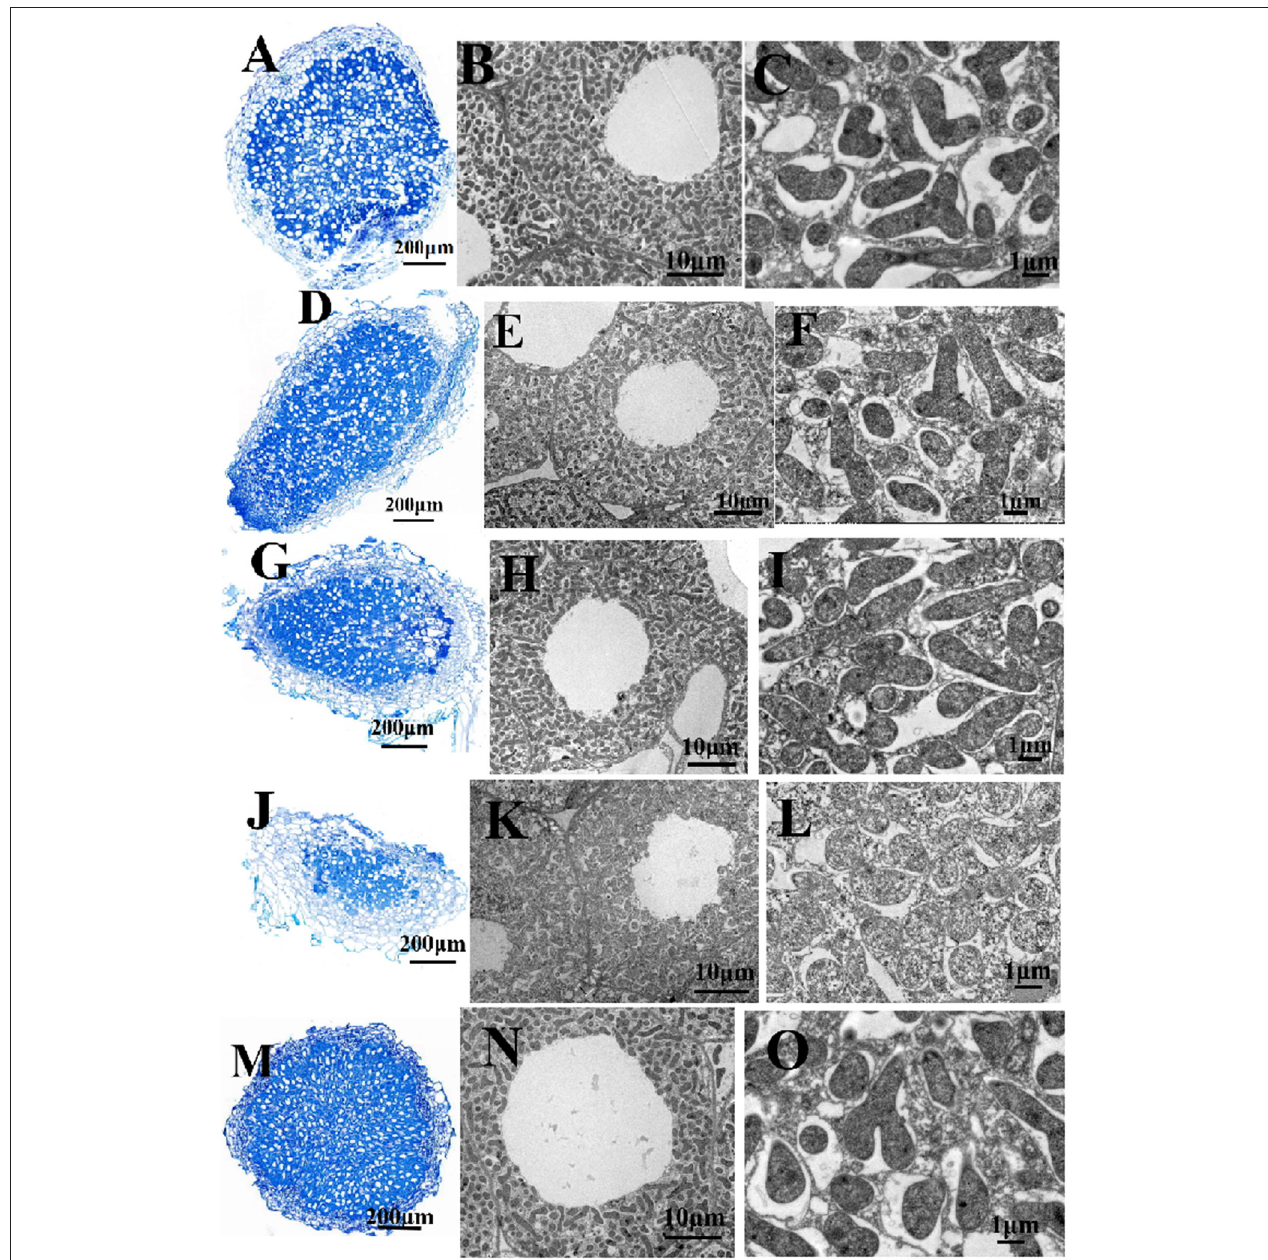
FIGURE 3 | Structure of pea nodules and bacteroids. Root nodules were induced by RL3841 (A–C) , RLgshR (D–F) , RLgpxA (G–I) , RLgshRgpxA (J–L) , RLgpxA(pBBRgpxA) (M–O) . Scale bars = 200 µ m (A,D,G,J,M) , 10 µ m (B,E,H,K,N) , 1 µ m (C,F,I,L,O) .